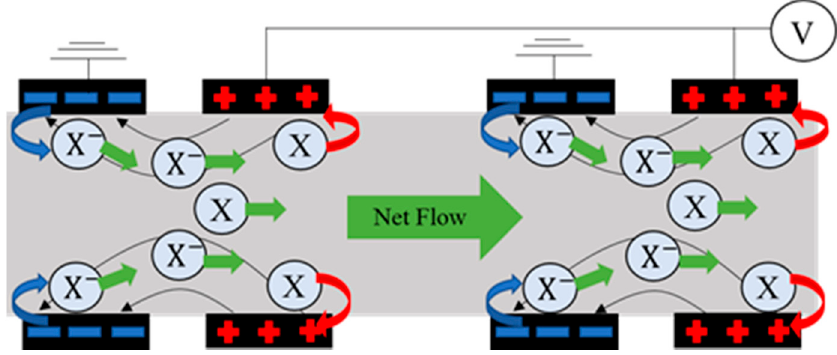
Figure 1. Driving mechanism of EHD pump.